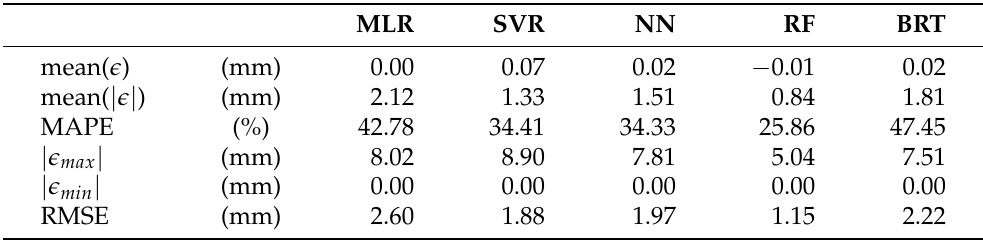
Table 4. Performance parameters for the MLR, SVR, NN, RF and BRT models regarding the training